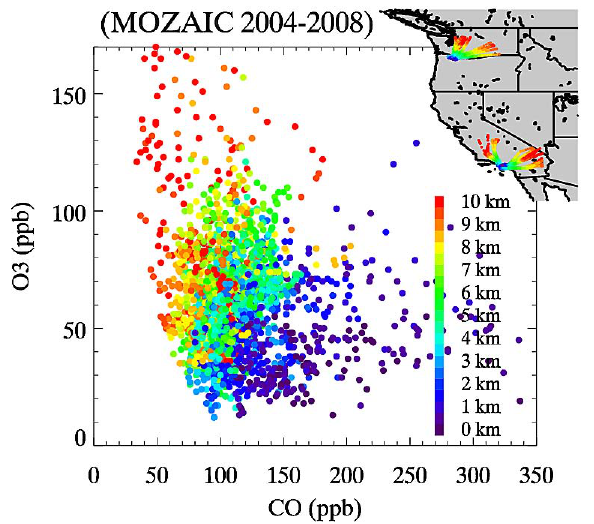
Fig. 8. As Fig. 3 but for MOZAIC CO and O 3 data. The location of the MOZAIC profile measurements for June and July of 2004–2008 is shown in the